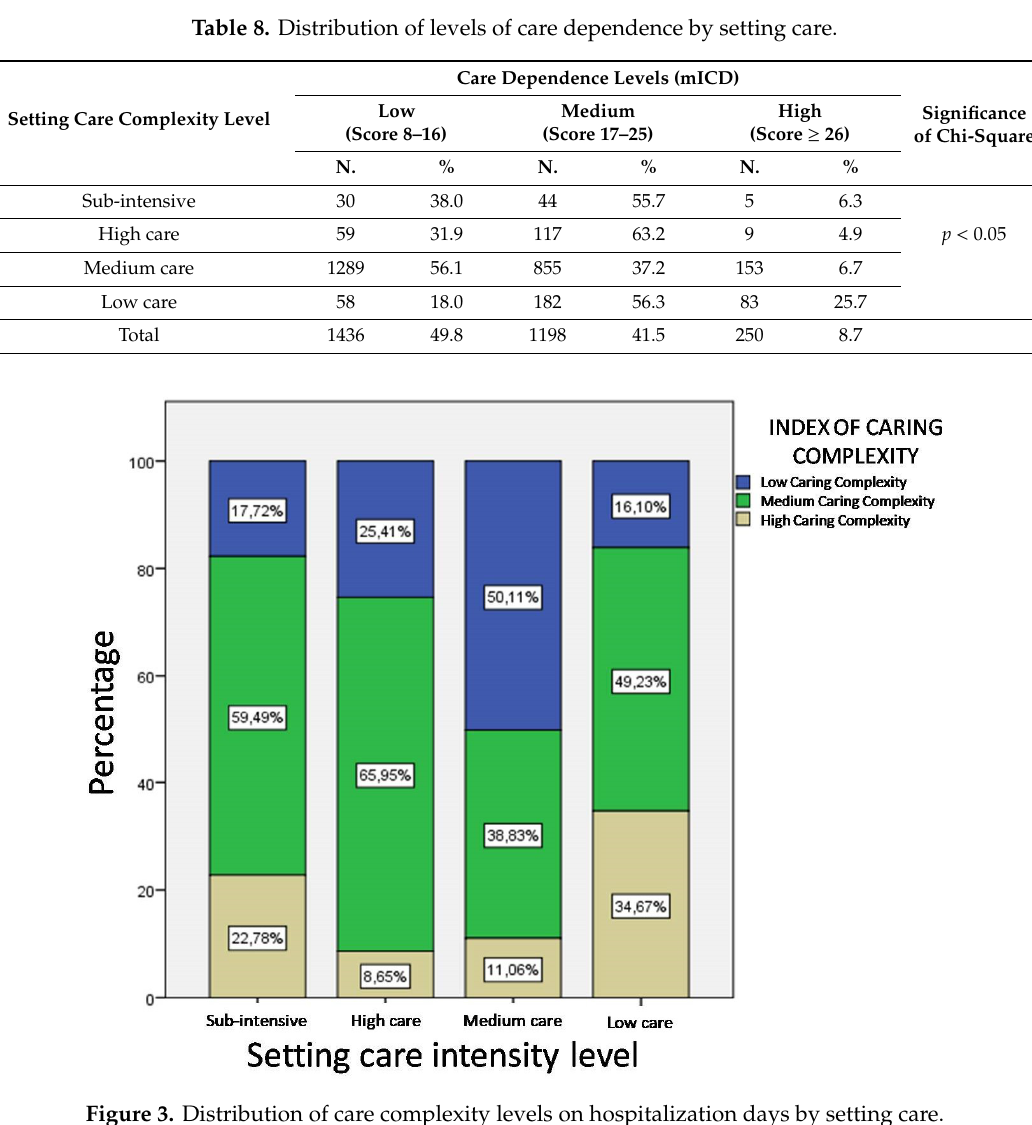
Figure 3. Distribution of care complexity levels on hospitalization days by setting care.